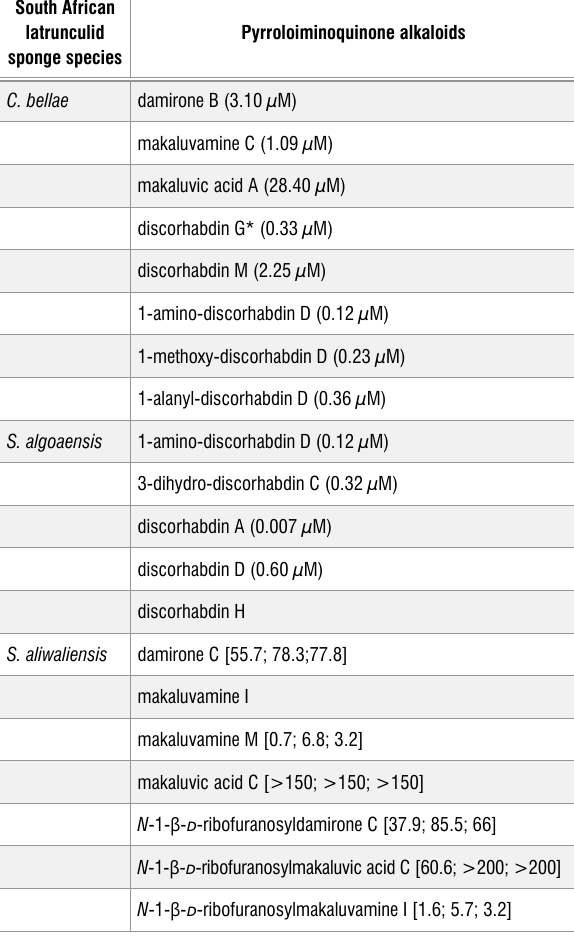
Pyrroloiminoquinone alkaloids isolated from Cyclacanthia bellae , Strongylodesma algoaensis and S. aliwaliensis . IC (µM) cytotoxicity towards either human colon tumour cell line (HCT 116) 12 or oesophageal cancer cell lines (WHCO1; WHCO6; KYE30) 40 presented in parentheses. The paucity of discorhabdin H and makaluvamine I isolated from S. algoaensis and S. aliwaliensis respectively, prevented an investigation of their cytotoxicity towards either human colon tumour or oesophageal cancer cell